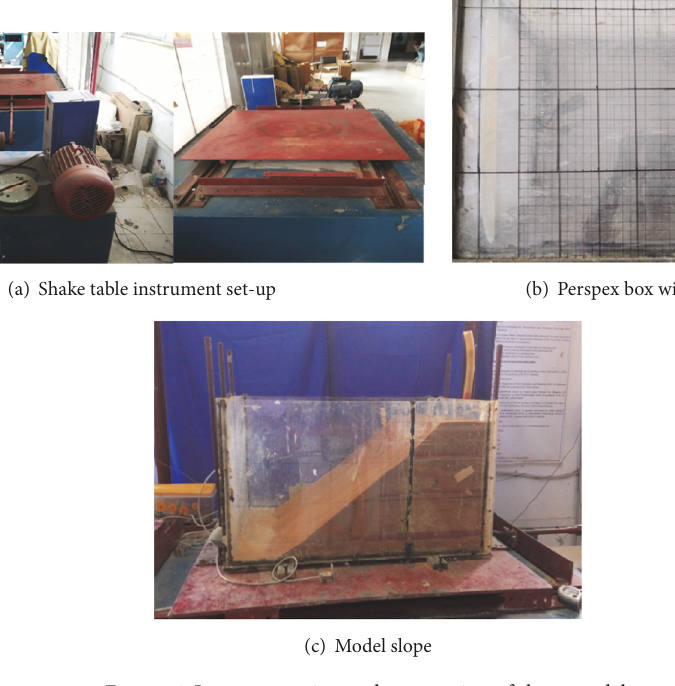
Figure 1: Instrumentation and preparation of slope model.